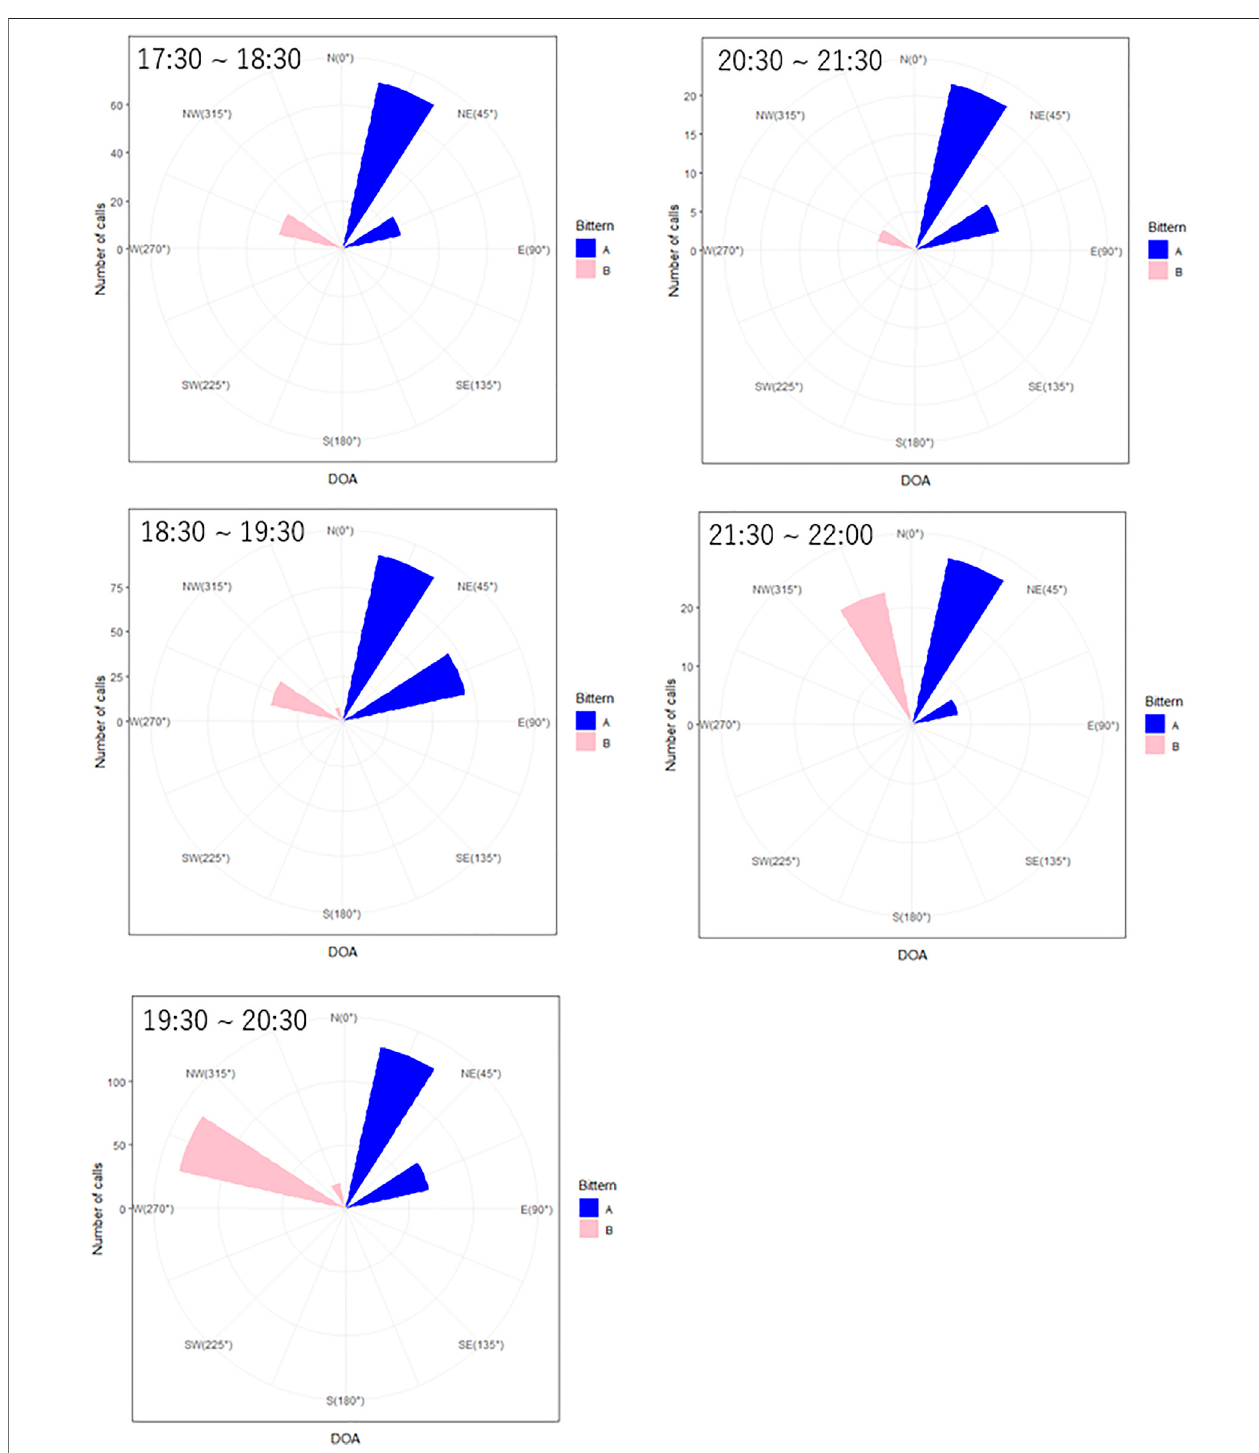
FIGURE 11 | Circular histogram of the direction of arrival (DOA) of the two bitterns ’ calls.